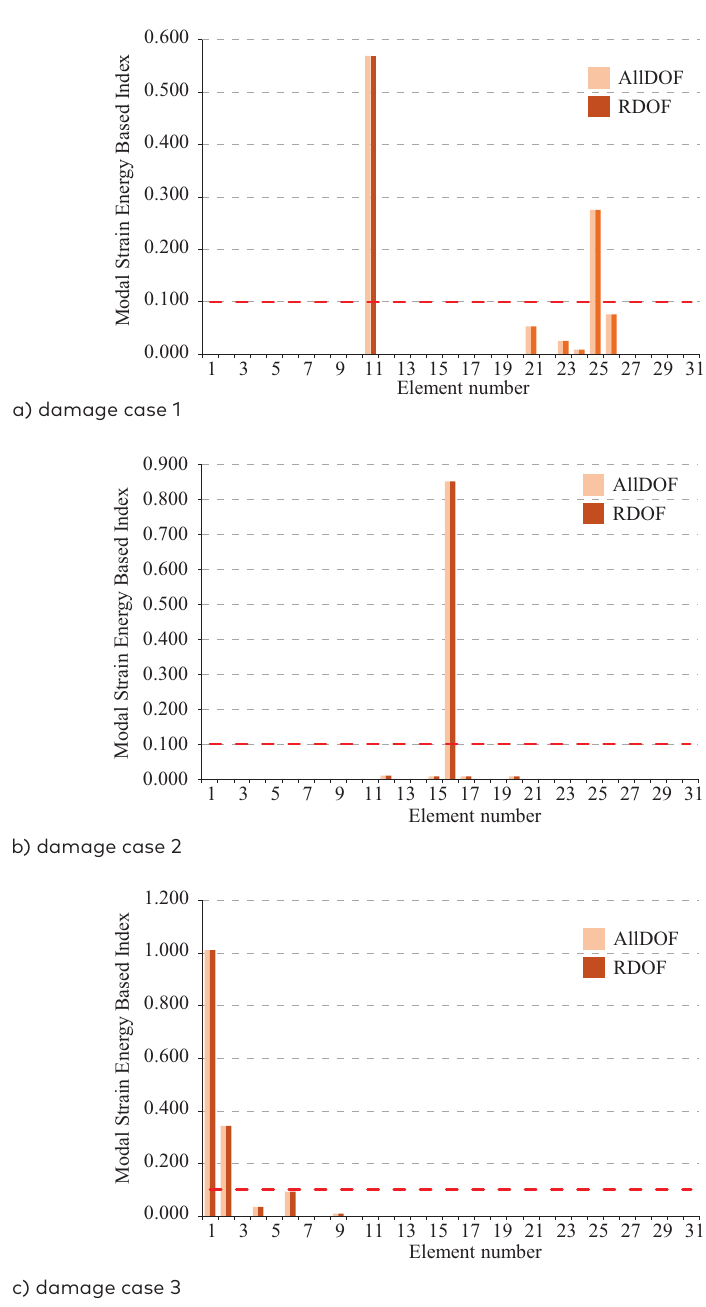
Figure 7. Damage index values in 31-element truss for five modes without